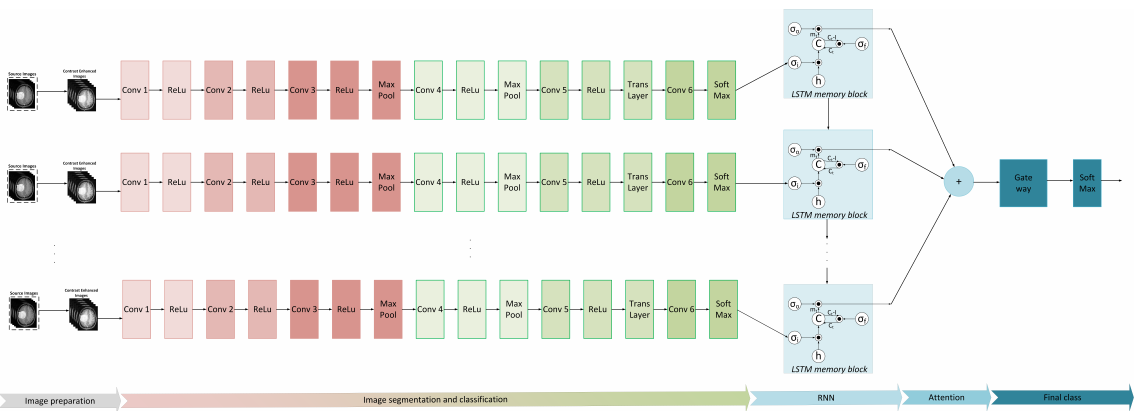
Figure 6. Structure of the MobileNetV2 and LSTM hybrid network ( σ o -output gate; σ i -input gate; σ f -forget